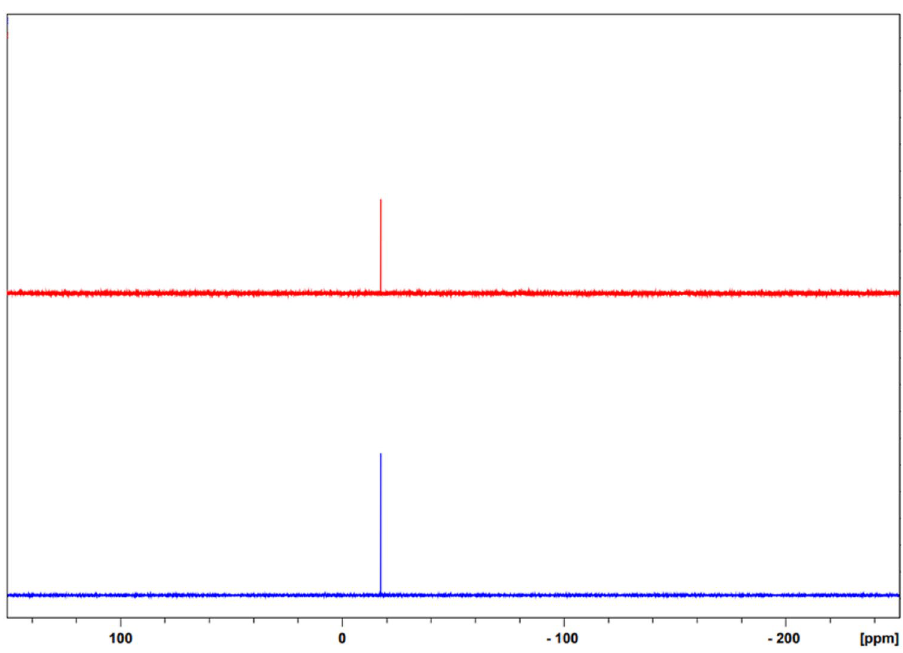
Figure 4. 31 P NMR spectra of the white precipitate (upper) and authentic TPP(lower) in DMSO- d 6